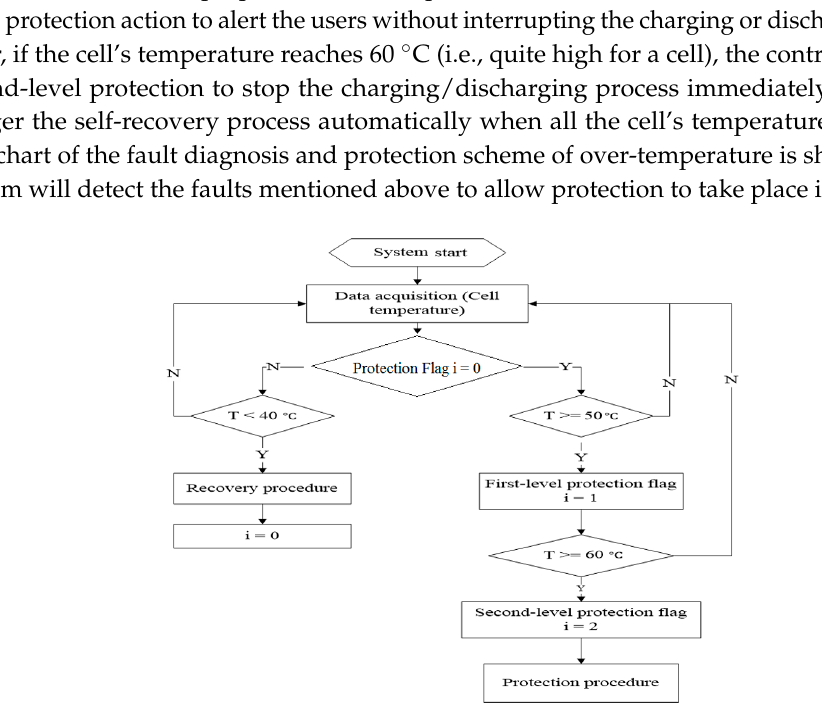
Figure 6. Flowchart of the fault diagnosis and protection scheme for high